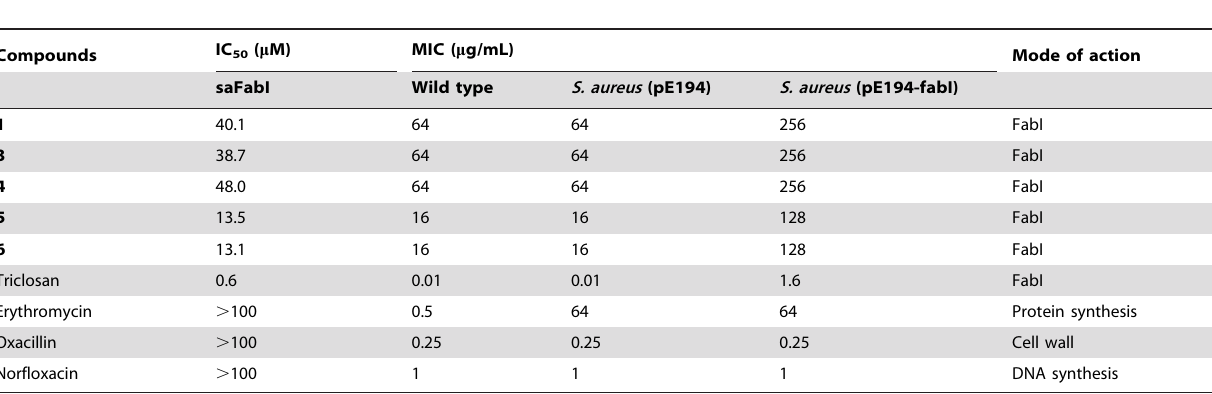
Table 2. Reduced susceptibility of fabI -overexpressing Staphylococcus aureus to meleagrin ( 1 ) and its derivatives.